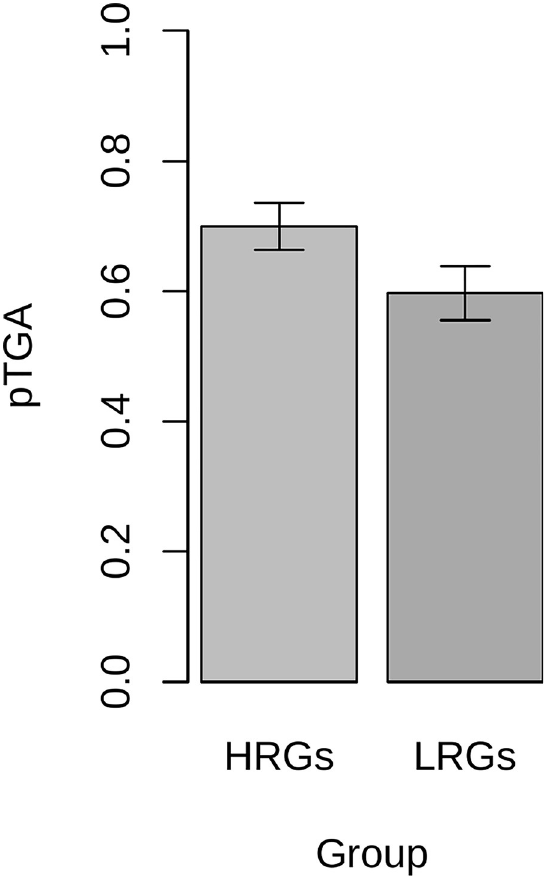
Fig 4. pTGA derived from TAA ! TGA and TGA ! TAA flux for the top 50% of genes by recombination rate (HRGs) and bottom 50% of genes by recombination rate (LRGs) in the human genome. pTGA is calculated as 1/(1 +(TGA ! TAA/TAA ! TGA)) and hence represents the balance between the 2 dominant stop codon flux events. Error bars show standard deviation calculated from 10,000 bootstraps generated by resampling genes in each bin with replacement. Underlying data can be found in S4 Data. HRG, highly recombining gene; LRG, lowly recombining gene; pTGA, predicted TGA usage.